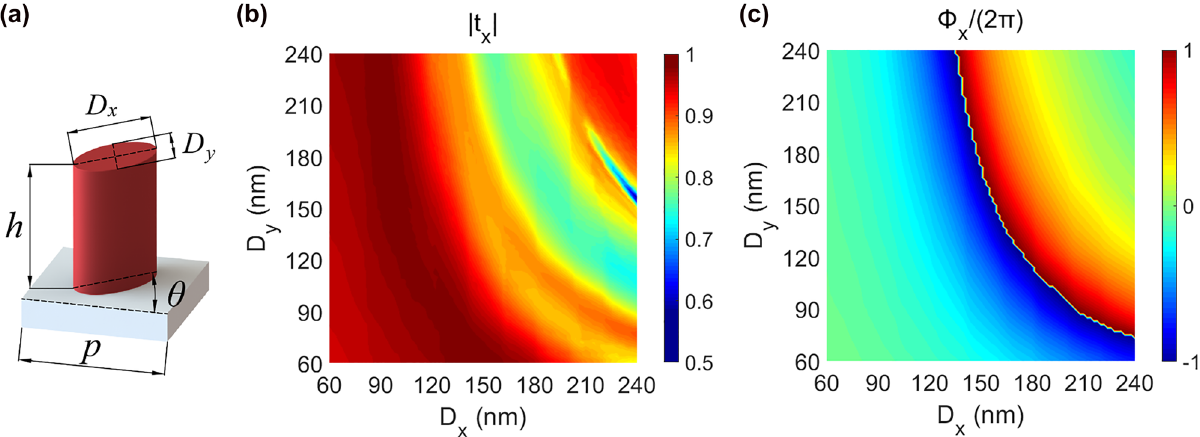
Figure 2: Design of the metasurface. (a) Schematic diagram of the elliptical silicon pillar, the substrate is silica. (b) and (c) Calculated transmittance and phase shift of a single period for X-LP normal incident light with a wavelength of 780